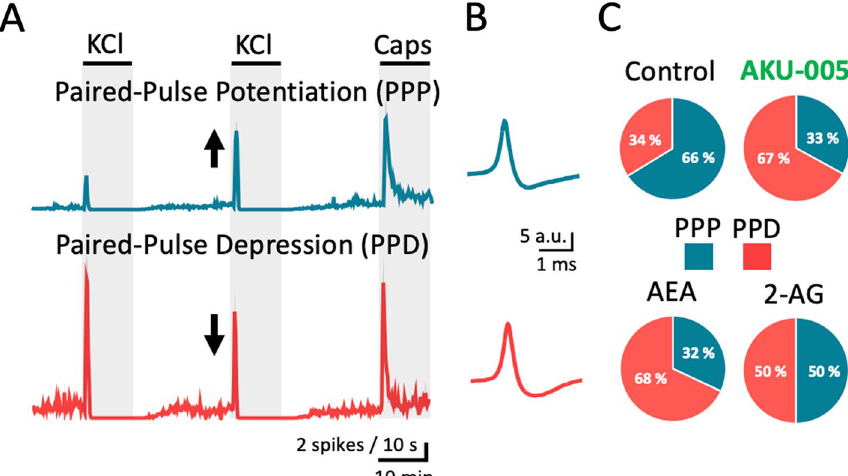
Fig. 8 AKU‑005 and AEA promote paired‑pulse depression in meningeal afferents. A Time courses of spike frequency (10‑s bin size) induced by APs recorded from the peripheral part of trigeminal nerve innervating rat meninges within the 1‑min active phase of the 2 nd KCl pulse. By clustering the recordings, we defined paired‑pulse potentiation (PPP) when the number KCl‑evoked APs was higher during the 2 nd KCl pulse and